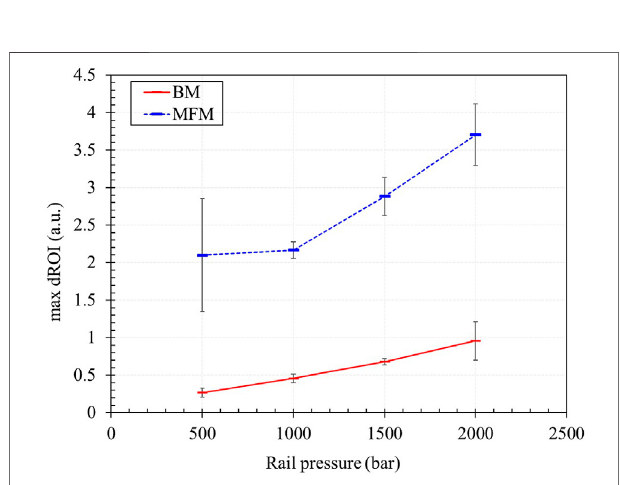
FIGURE 7 | Comparison of the maximum rise rate of the ROI at different injection pressures.